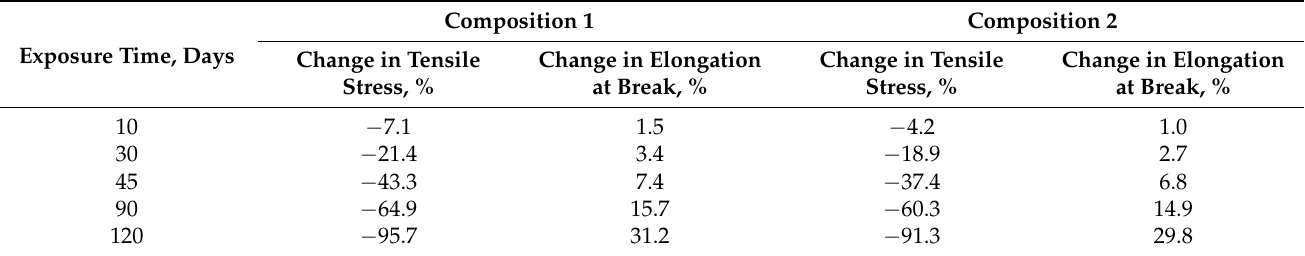
Table 7. Changes in the physical and mechanical characteristics of PVC